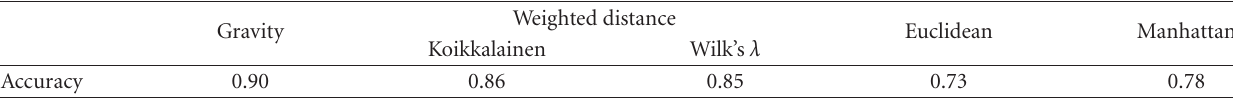
Table 2: Model results.